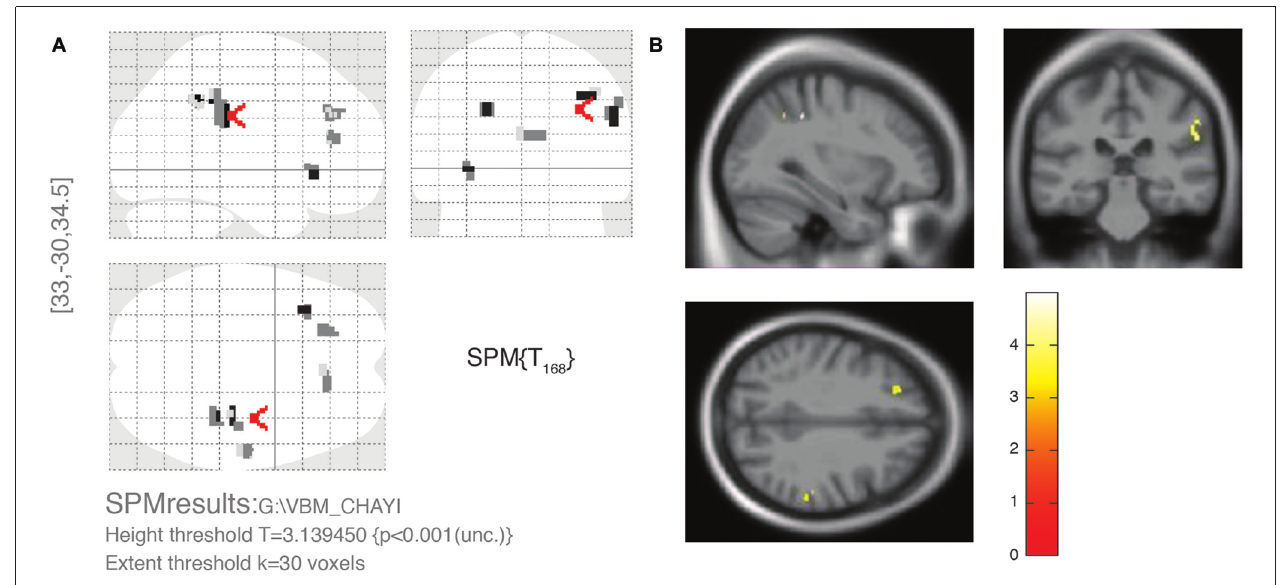
FIGURE 2 | Voxel-based morphometry (VBM) results of gray matter (GM) atrophy in OPVHs patients compared with CN. (A) Statistical parametric mapping (SPM) results in various brain regions. (B) GM atrophy was found in the right supramarginal gyrus, right angular gyrus, right middle temporal gyrus, right anterior cingulum and left insula compared to the CN ( P < 0.001, uncorrected, with 30-voxel clustering criteria).